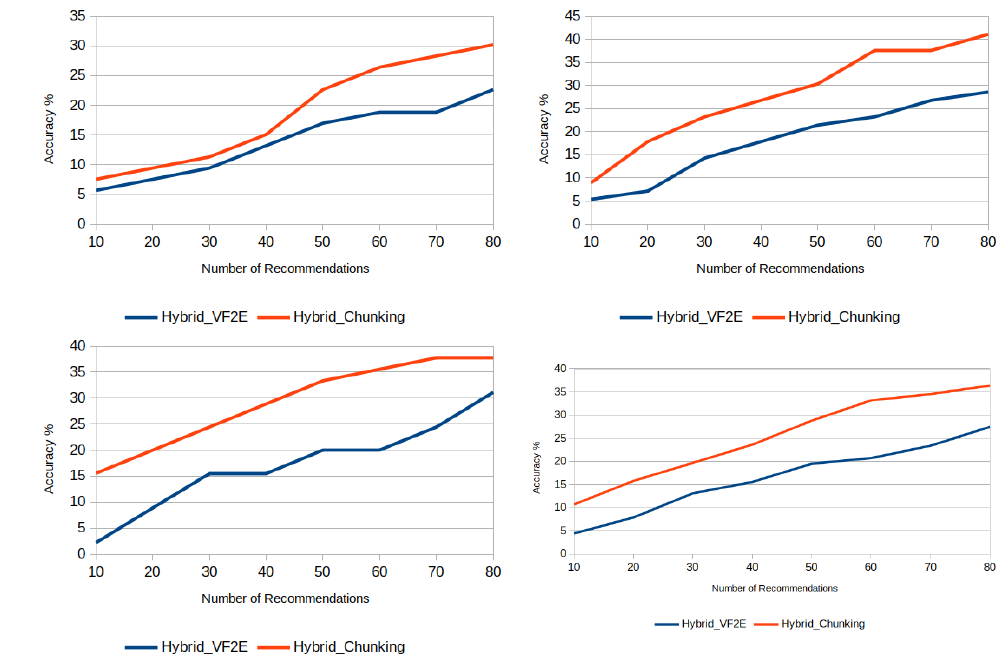
Figure 11. Performance comparison of proposed Hybrid_Chunking technique with baseline methods (VF2E) for a group of three users in each graph and the average results graph of these